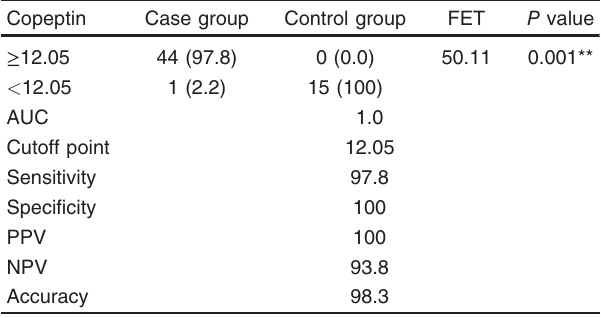
Table 11 Validity of copeptin as a predictor of disease severity Copeptin